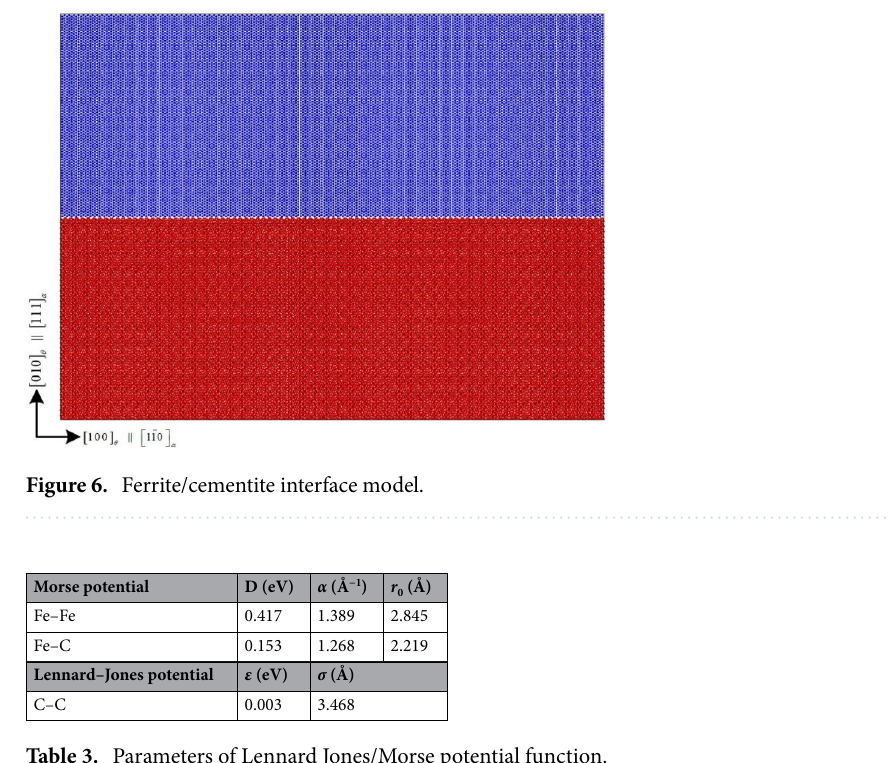
Table 3. Parameters of Lennard Jones/Morse potential function.